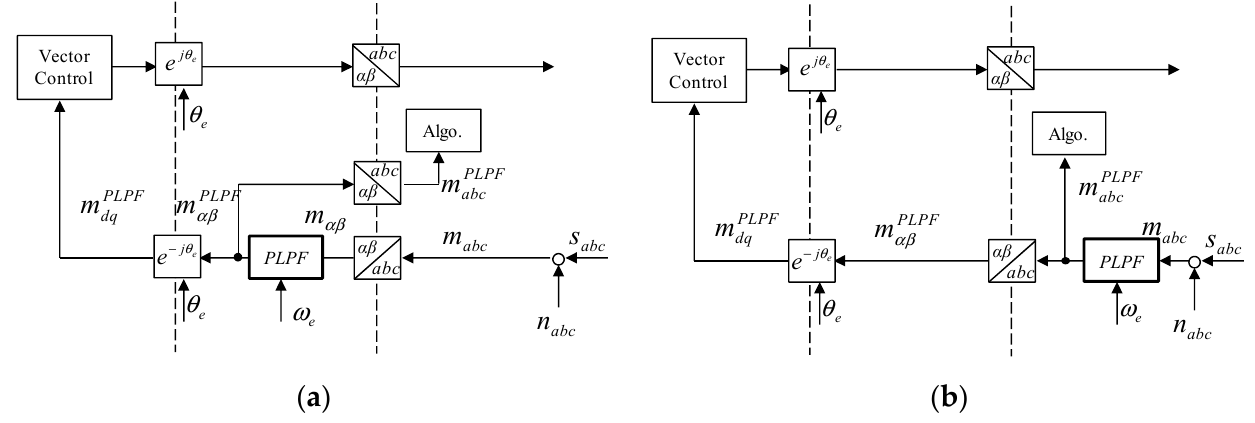
Figure 6. Comparison of signal flows between ( a ) the conventional PLPF and ( b ) the extended PLPF. In contrast to the conventional PLPF, the extended PLPF can directly provide the filtered three-phase variables to the algorithm. The extended PLPF is more useful for making signal flows clear and intuitive when organizing the algorithm, as shown in Figure 6b. the PLPF are discretized by using the backward Euler approximate